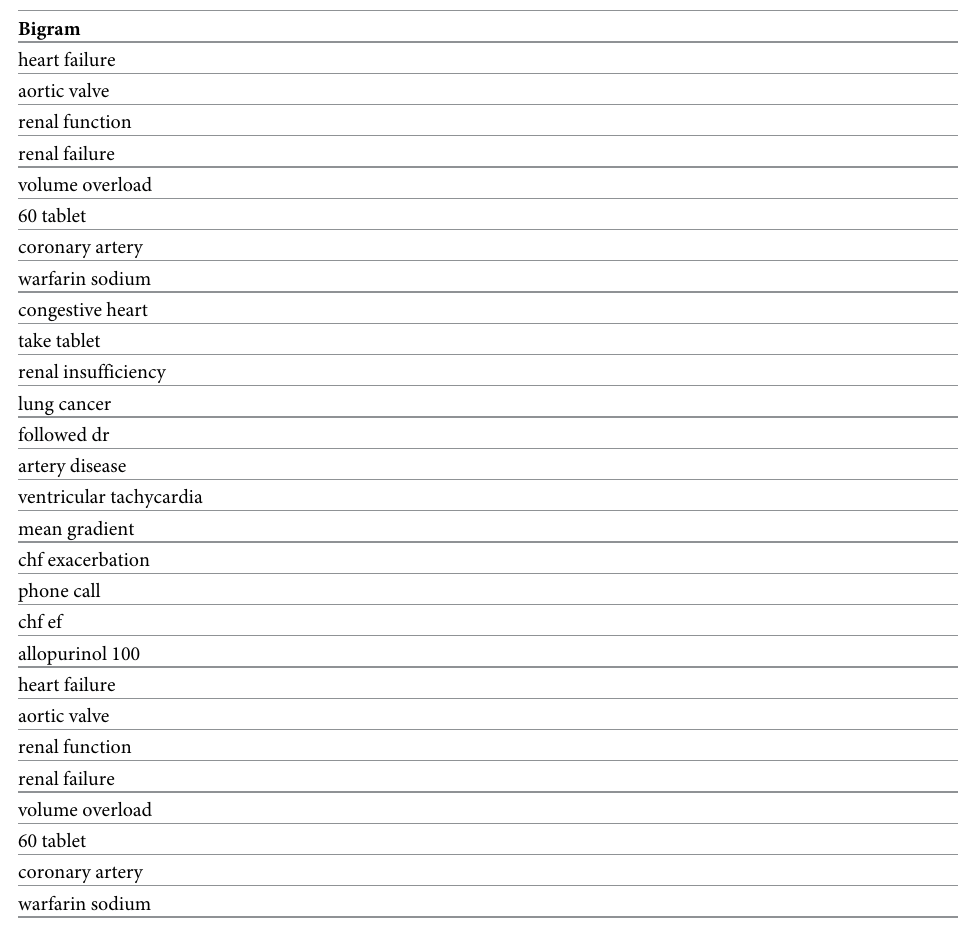
Table 3. Examples of bigrams extracted from clinical notes, listed in order of relative importance ranked by local mutual